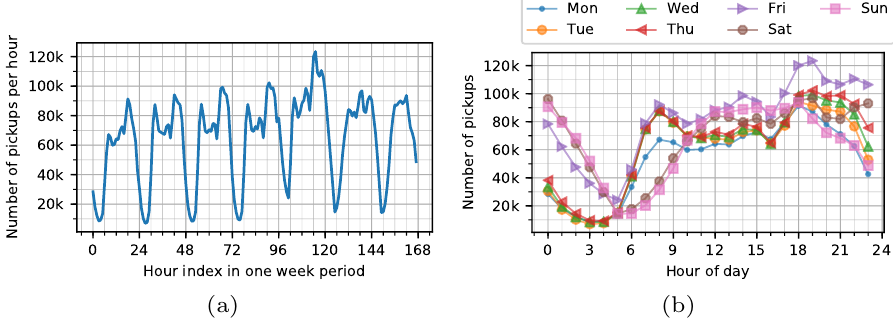
Figure 2. Temporal distribution of hourly taxi order along one week period ( a ) and over day of week ( b